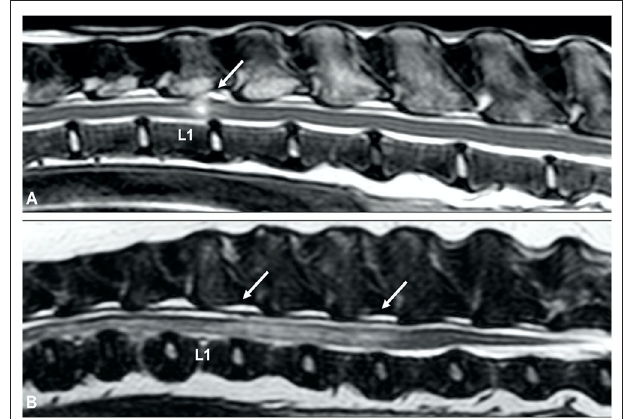
FIGURE 12 | T2-weighted sagittal MR images of (A) an 8-year old cross breed with ANNPE and (B) a 4-year old Staffordshire Bull terrier with ischemic myelopathy. (A) Focal hyperintensity can be seen overlying the L1-L2 intervertebral disc. The L1-L2 intervertebral disc space is narrowed and has a reduced volume of T2W hyperintense nucleus pulposus. (B) A relatively well-demarcated longitudinal hyperintensity can be seen between L1 and